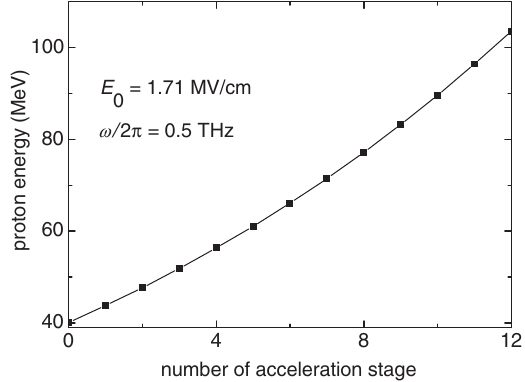
¼ v (cid:3) (solid line), FIG. 3. Proton energies after subsequent units of a 12-stage THz THz > v (cid:3) (dotted line) THz accelerator THz THz